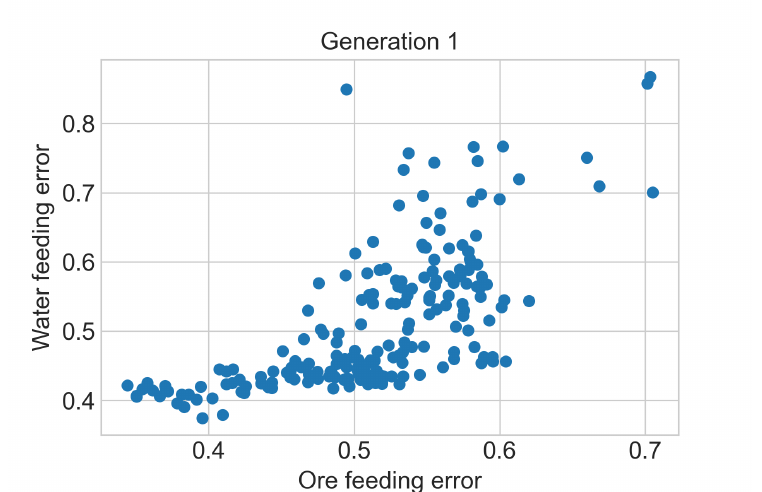
Figure 5. Simulation diagram of the first generation.